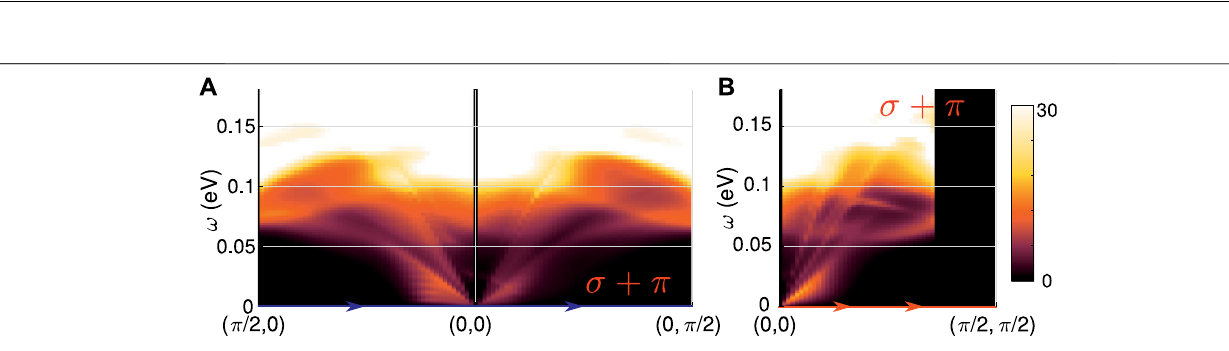
Frontiers in Physics |